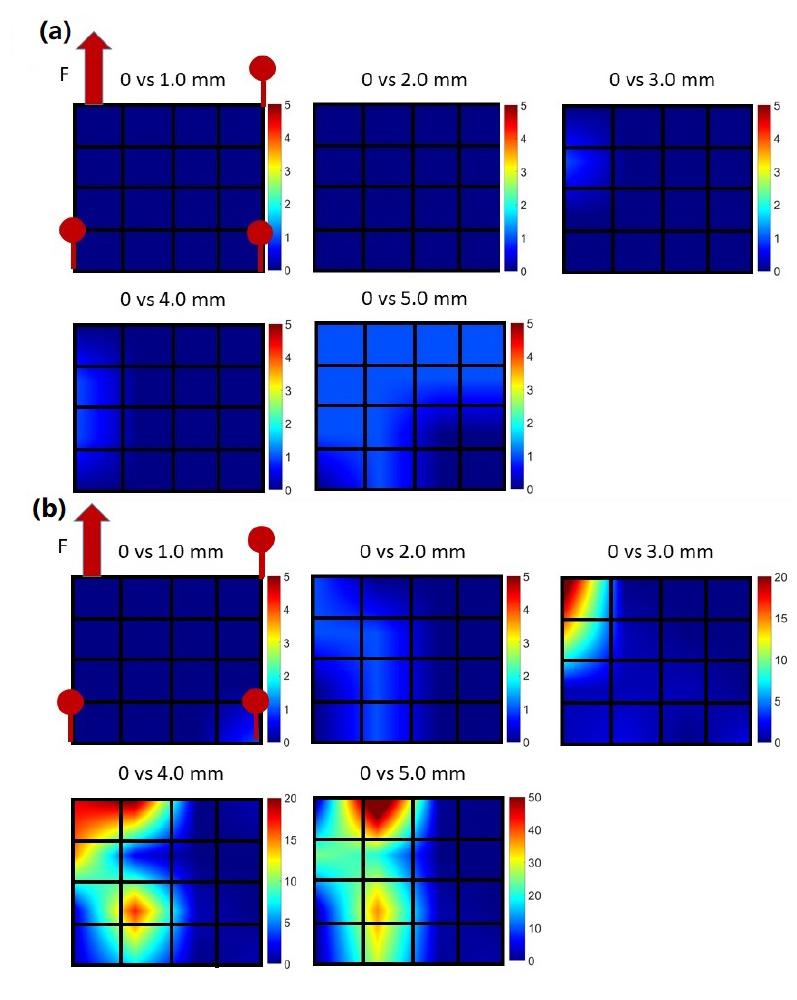
Figure 9. Muscle movement imaging for ( a ) porcine tissue#2 and ( b ) porcine tissue#1. The color bar represents the relative displacement of the muscle. The displacement was calculated using T0 as the reference.